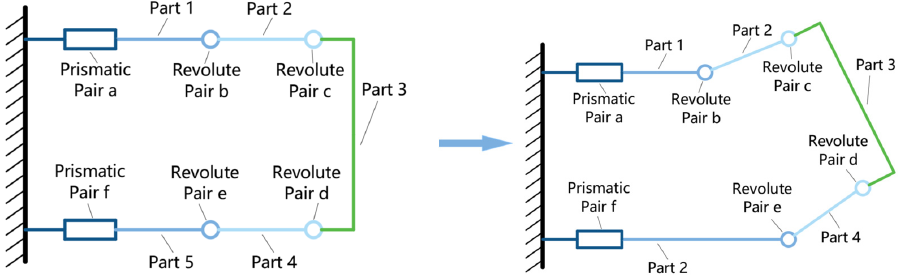
Figure 3. A simplified model of the flexible panel continuum mechanism.